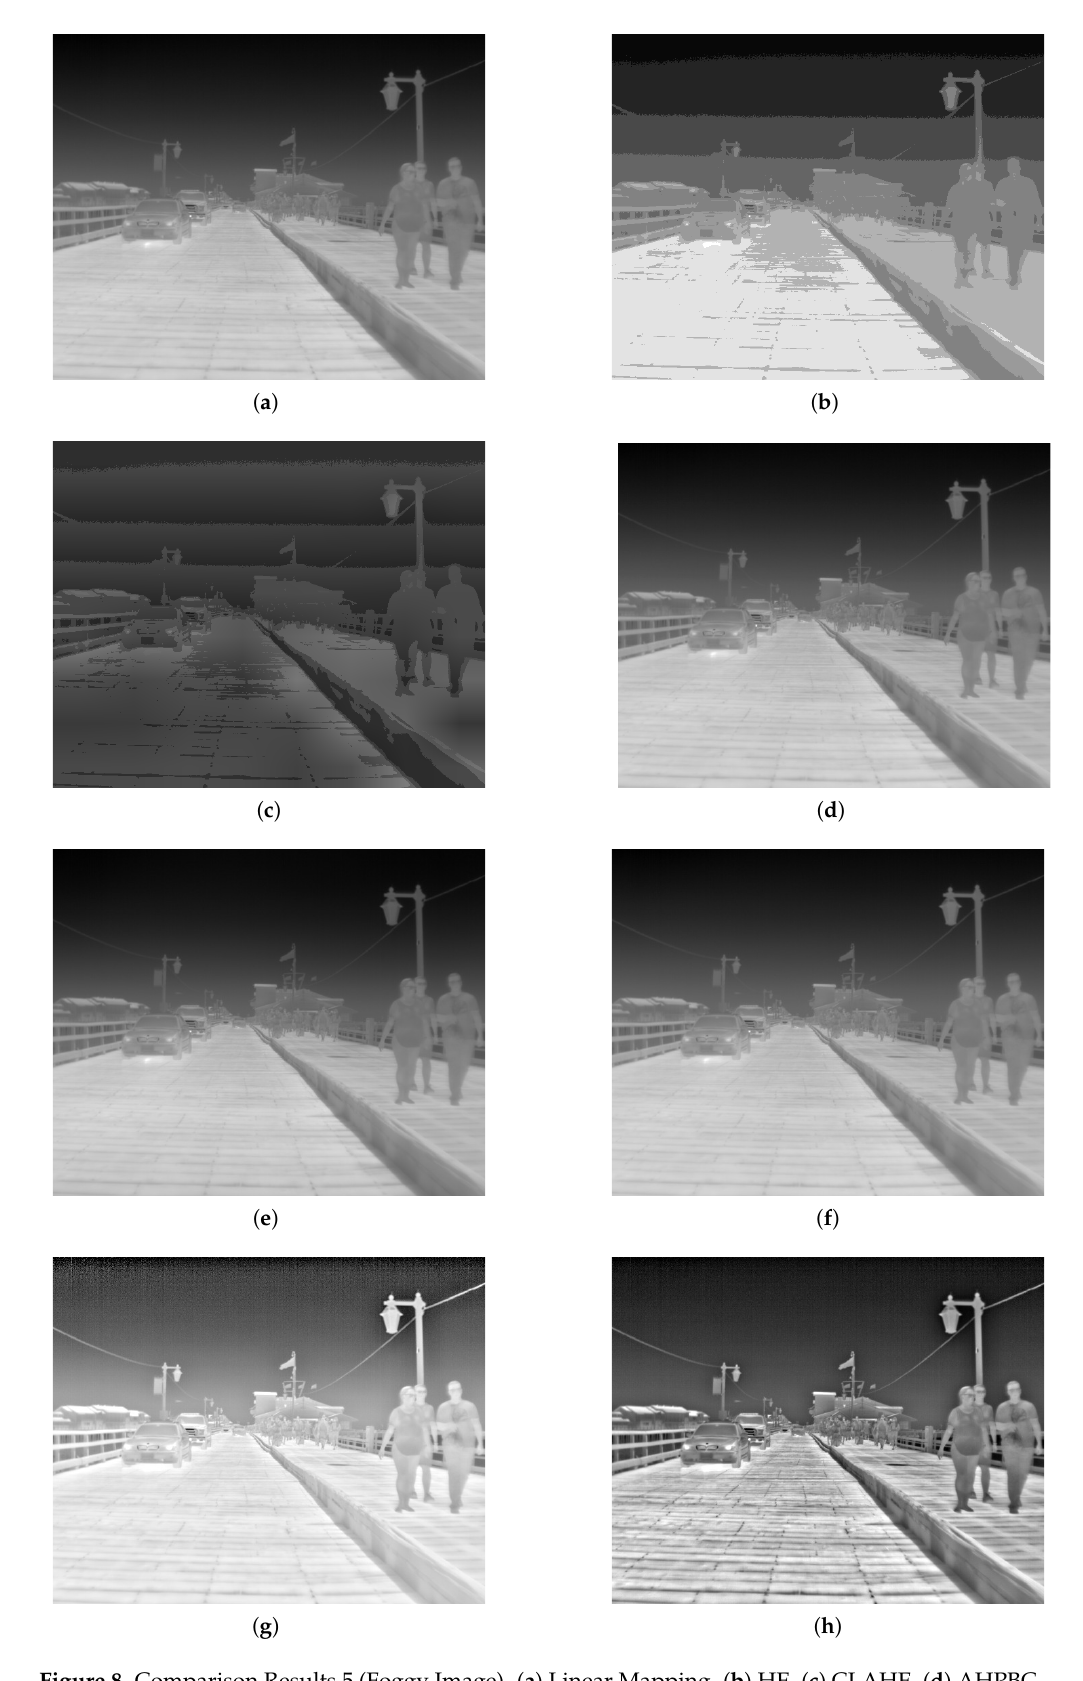
Figure 8. Comparison Results 5 (Foggy Image). ( a ) Linear Mapping. ( b ) HE. ( c ) CLAHE. ( d ) AHPBC. ( e ) MSR. ( f ) Reinhard. ( g ) LEP. ( h ) Proposed